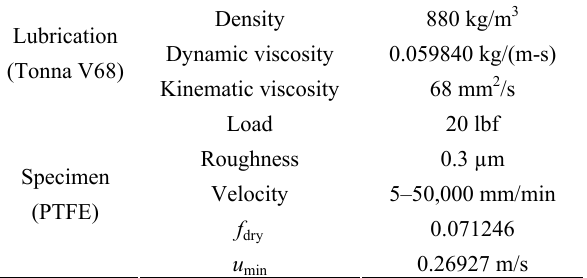
Fig. 15 Numerical simulation to predict COF under given load. Table 3 Initialization of variables in simulation.